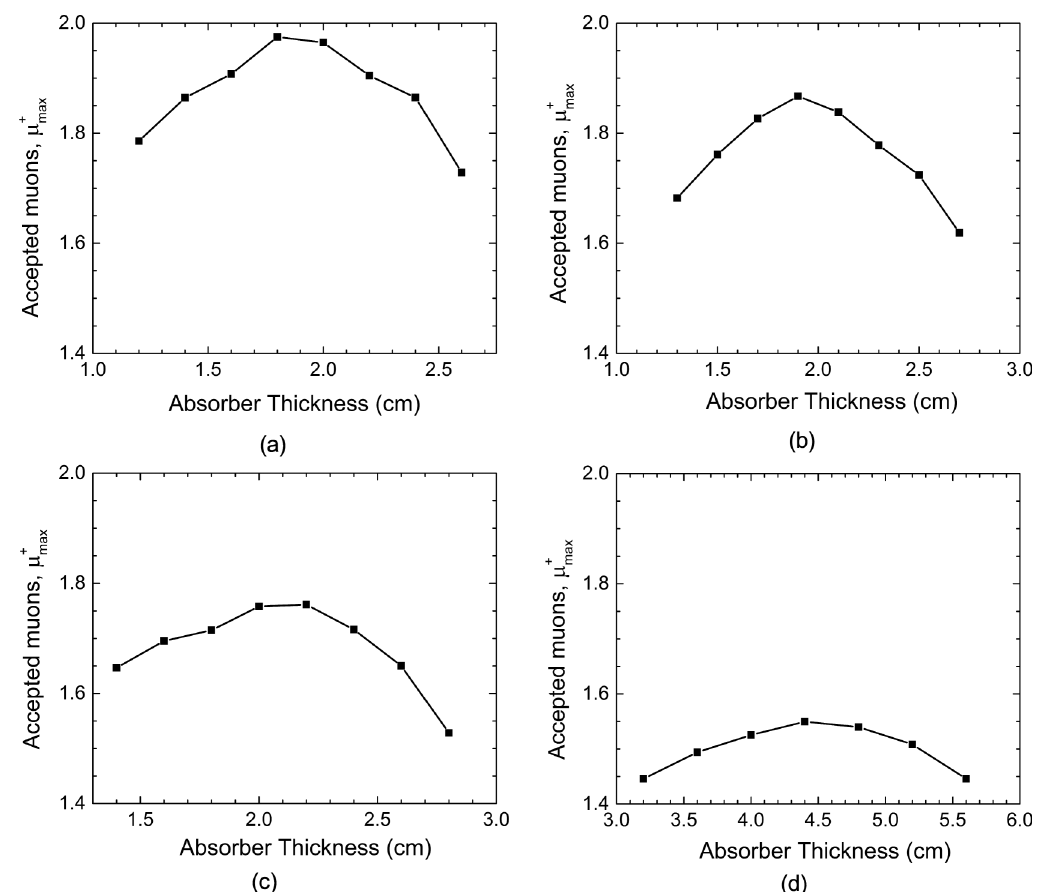
FIG. 9. ICOOL simulation results of the accepted muon yield for different absorber lengths per cell: (a) BASE, (b) RBC, (c) LBC, and (d) ICL